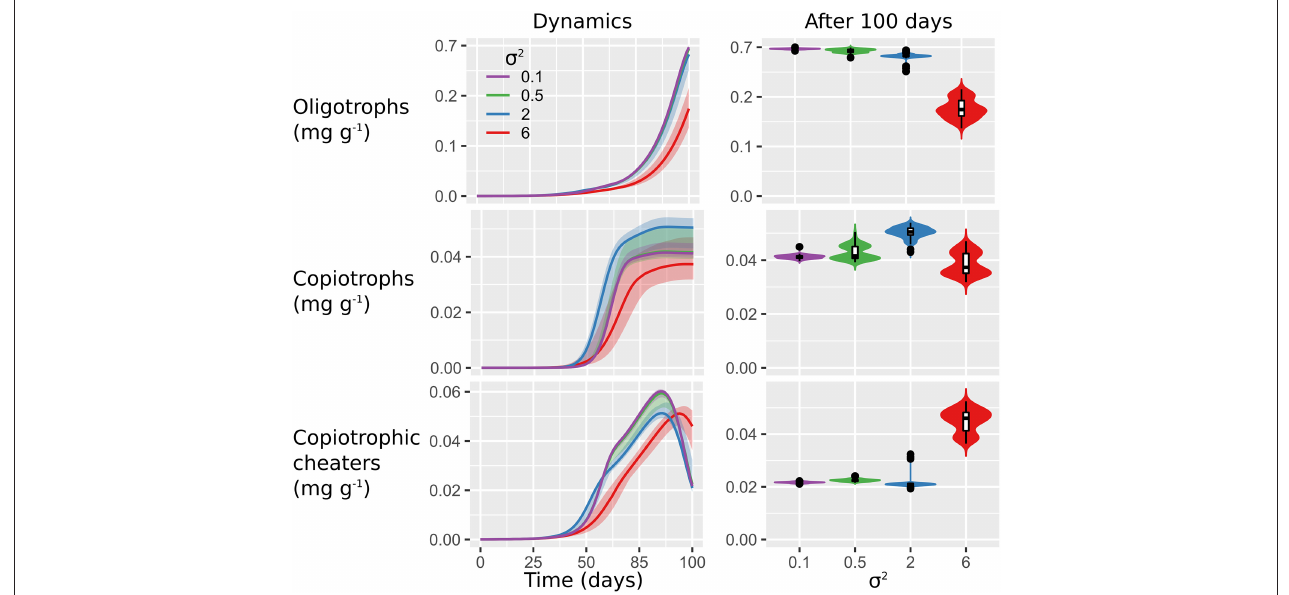
FIGURE 5 | Microbial biogeography most strongly affects dynamics of fast-growing copiothrophs. Plots show the succession (left) and final values (right) of microbial functional groups (total biomass) in response to spatial heterogeneity of the initial distribution of microorganisms ( σ 2 = 0.1, 0.5, 2, 6). Values are aggregated over the 100 × 100 mm 2 soil domain. Lines indicate the medians of 100 realizations and shaded areas show minimum and maximum values (left). Violin plots (right) are scaled to the same width and show the relative distribution of final values. In the inserted box plots, horizontal lines indicate median values, boxes show interquartile ranges (IQR), and whiskers reflect values within maximum 1.5 ×